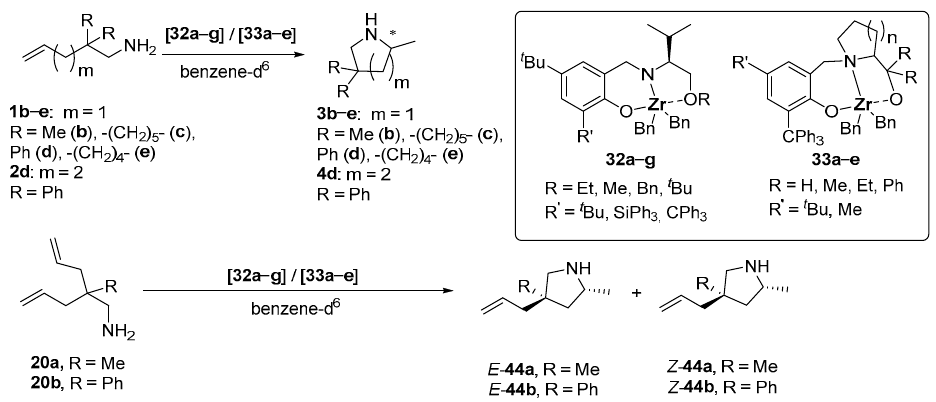
Figure 3. Proposed catalytic cycle explaining the concentration-dependent Z / E selectivity with an exchanging two-site catalytic model